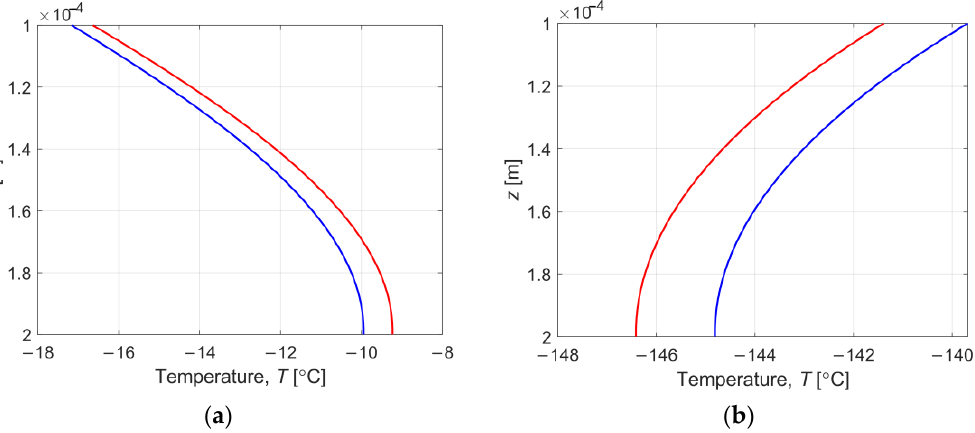
Figure 10. Interval temperature in the cross-section of the sample at simulation time t = 0.04 s: ( a ) for cooling; ( b ) for warming.